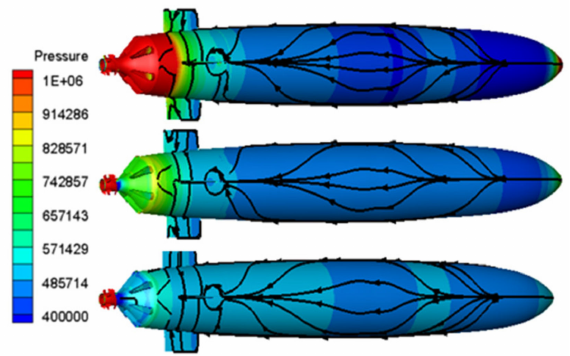
Figure 7. Overview pressure and streamline on the navigation body.